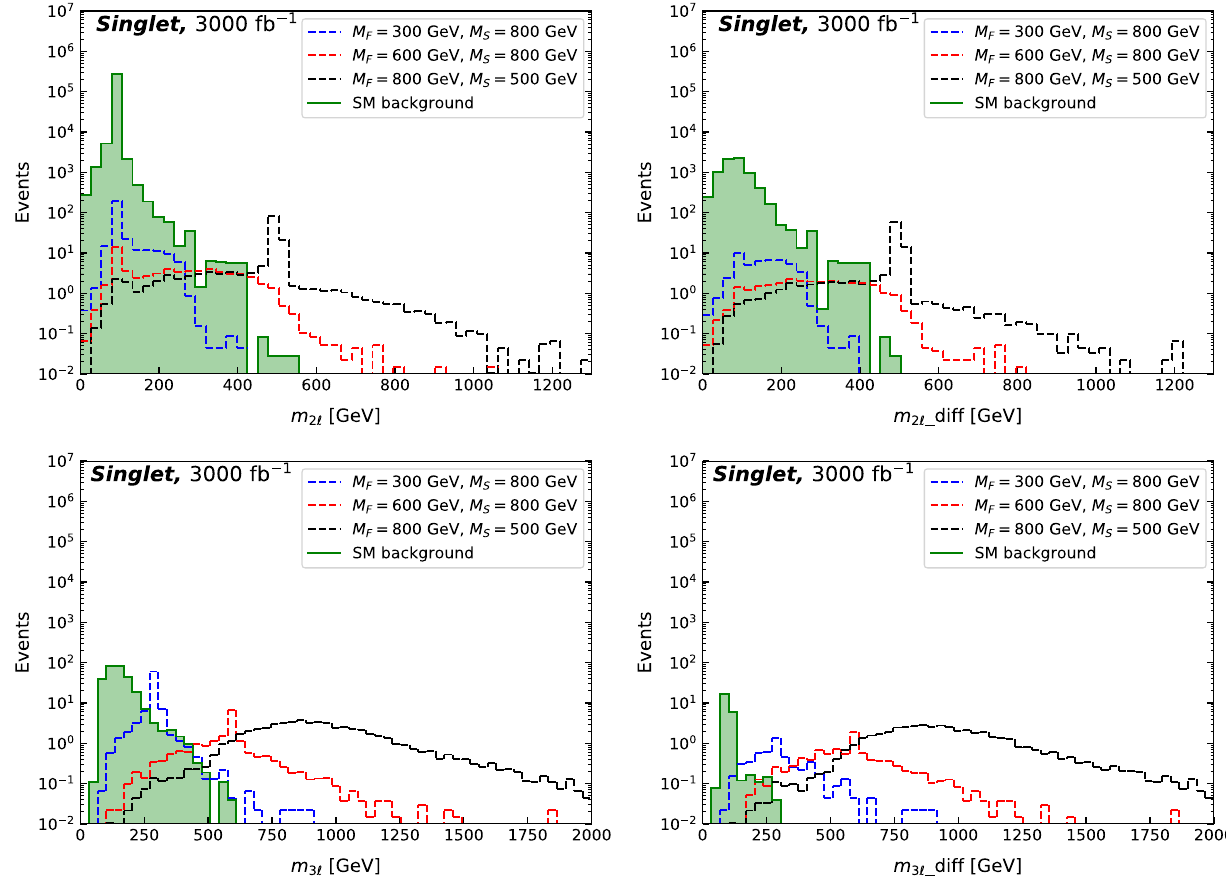
scalar masses at a luminosity of 3000 fb − 1 and coupling κ (cid:4) is fixed according to Eq. (6) √ s = 13 TeV and a luminosity of 150 fb − 1 and in parentheses for √ for s = 14 TeV and 3000 fb − 1 . We marked with * (**) the cases where the peaks fall under SM background (resonances are broad)